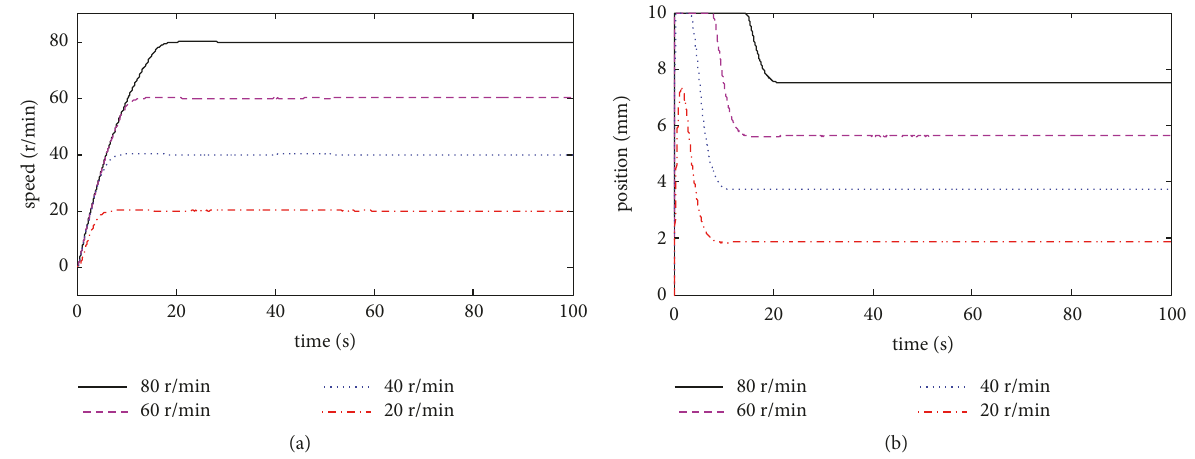
Figure 3: Speed regulation performances (a) and fuel index positions (b) at different set speeds.